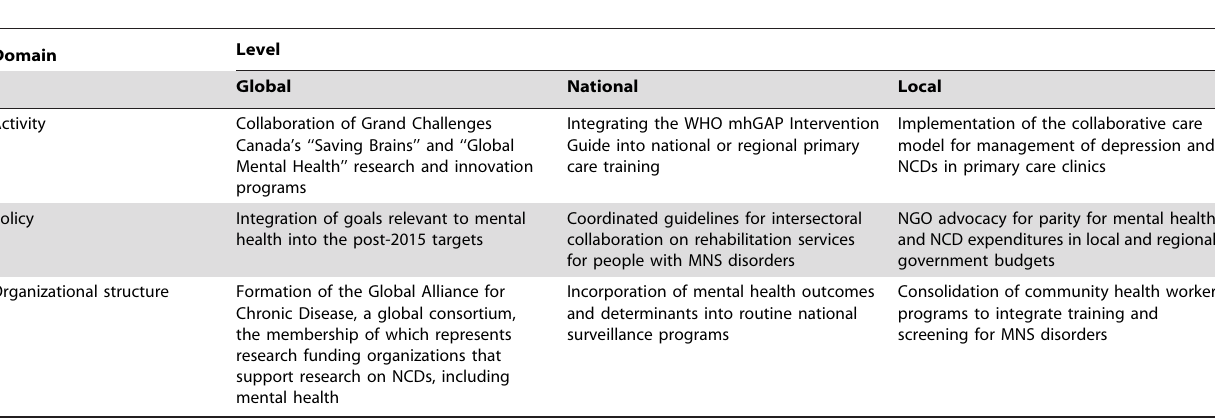
Table 1. Operationalizing integration: Examples of activity, policy, and organizational integration that link MNS research and care to other health-related